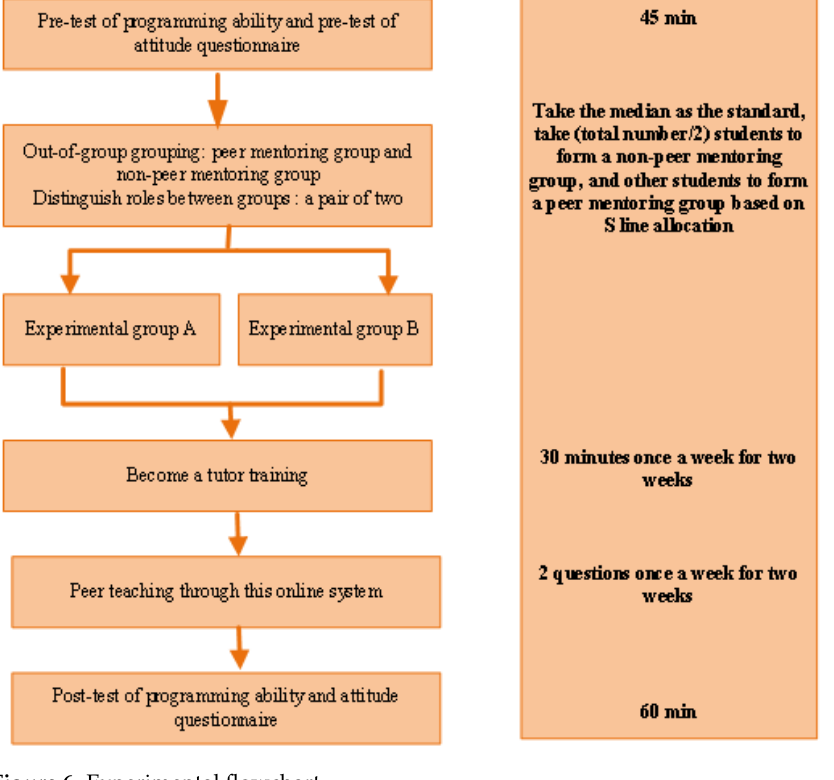
Figure 6. Experimental flowchart.